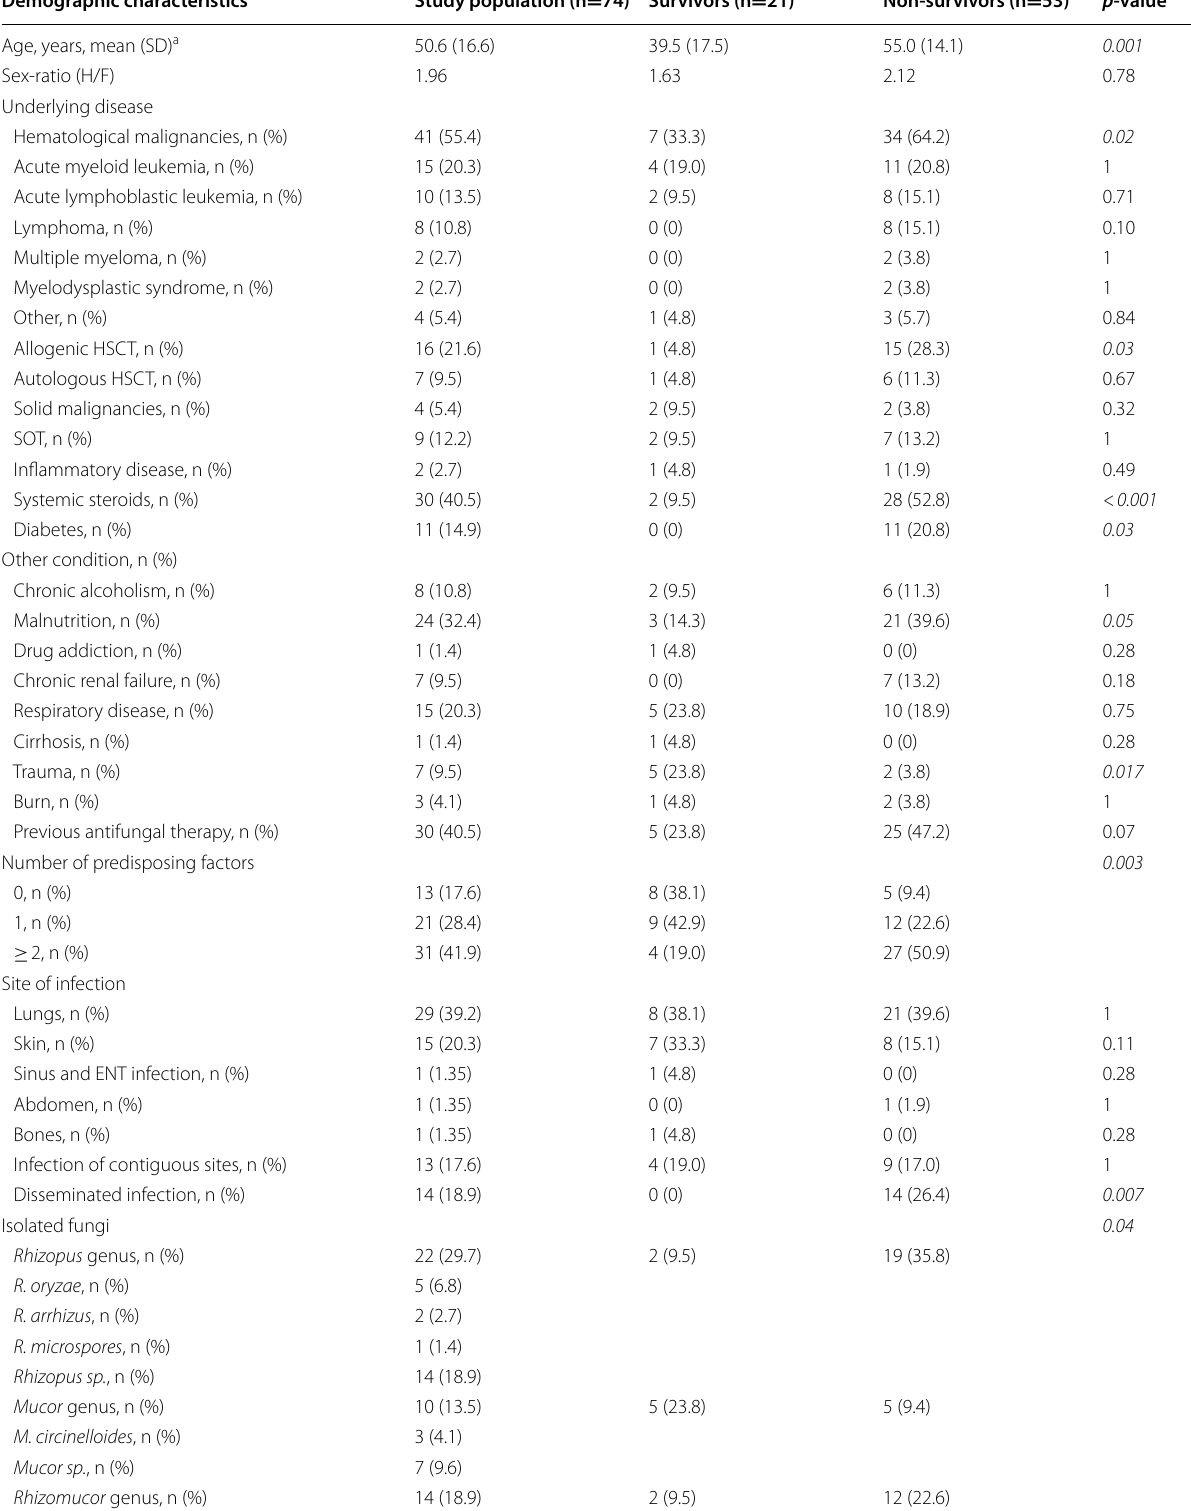
Table 1 Demographic and infection characteristics of the 74 cases of zygomycosis Demographic